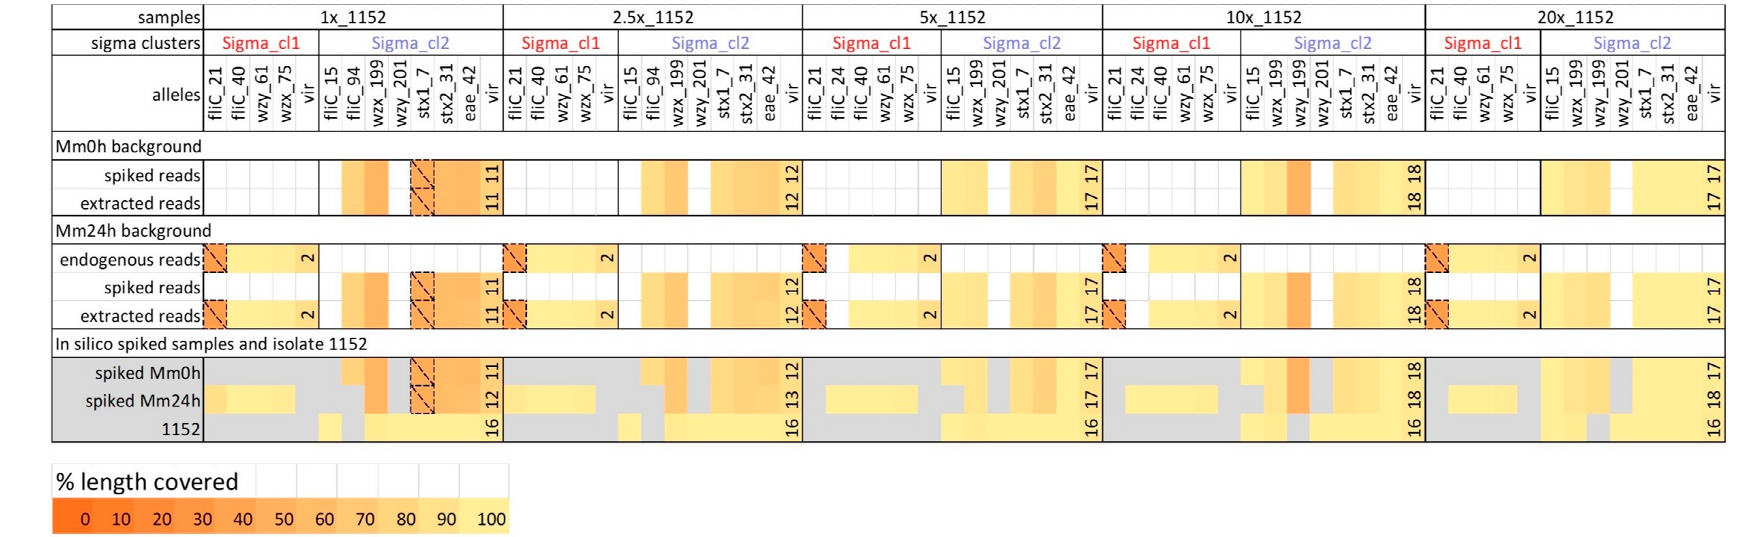
Figure 4. Strain-level analysis of in silico spiked metagenomic samples containing the strain TIAC1152 at different coverages: gene detection. Isolate TIAC1152 reads were down-sampled to different coverages (spiked reads) and spiked into the following metagenomic backgrounds: the non-enriched minced meat sample containing no endogenous E. coli strains (Mm0h background) and the enriched minced meat sample containing one more prevalent (endogenous reads) and one negligible endogenous E. coli strain according to Sigma (the latter strain contained no virulence or serotyping genes and is therefore omitted) (Mm24h background). The reads attributed to different Sigma clusters and thus presumably belonging to the different strains were extracted from the resulting in silico spiked metagenomic samples (extracted reads), and gene detection of the O- and H-type serotyping genes, STEC-specific virulence genes ( stx and eae ) and remaining virulence genes (vir) was performed. For the latter, only the total number of detected genes is shown (see Figure S4 for more details). The detected genes are grouped according to the Sigma clusters, in which the corresponding reads were retrieved. The line “endogenous reads” in the Mm24h background shows the genes observed in the main cluster extracted by Sigma from the unspiked Mm24h sample (Mm24h_Sigma_cl1). The lowest section of the table shows genes observed in the whole in silico spiked metagenomic samples prior to Sigma analysis (spiked Mm0h and spiked Mm24h) and in the non-downsampled sequencing data of isolate TIAC1152, the latter showing which serotyping and virulence gene alleles are expected for isolate TIAC1152. Cell color represents the percentage of the allele length covered by reads (%). Only alleles covered for more than 50% at least once are included in the table. Thereby, alleles that are covered below 50% are encased with dashed lines, and are not considered during interpretation of the results.